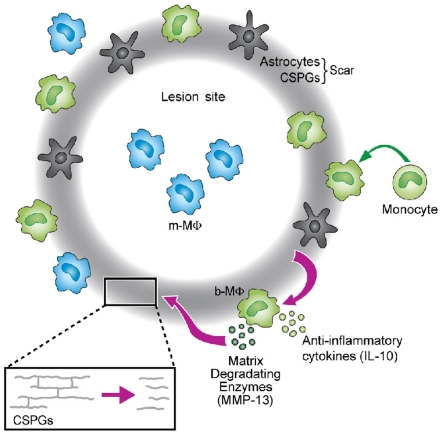
Schematic illustration of the mutual relationship between the resolving monocytes and the glial scar matrix.The glial scar matrix serves as a regulatory template, dictating the anti-inflammatory nature of the infiltrating monocytes that encounter it. In turn, the monocytes that used the scar for their own education regulate the scar degradation and resolution via the secretion of matrix degradation enzyme, MMP-13.